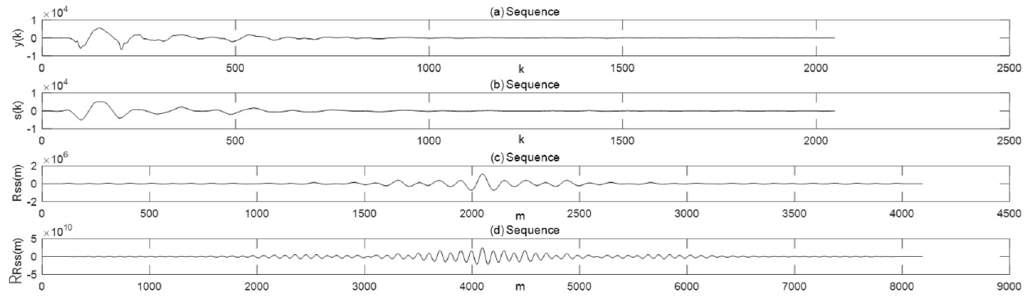
Figure 8. Signal denoising and enhancement . ( a ) Original sequence waveform; ( b ) waveform after wavelet denosing; ( c ) waveform after first self-correlation; ( d ) waveform after quadratic self-correlation.